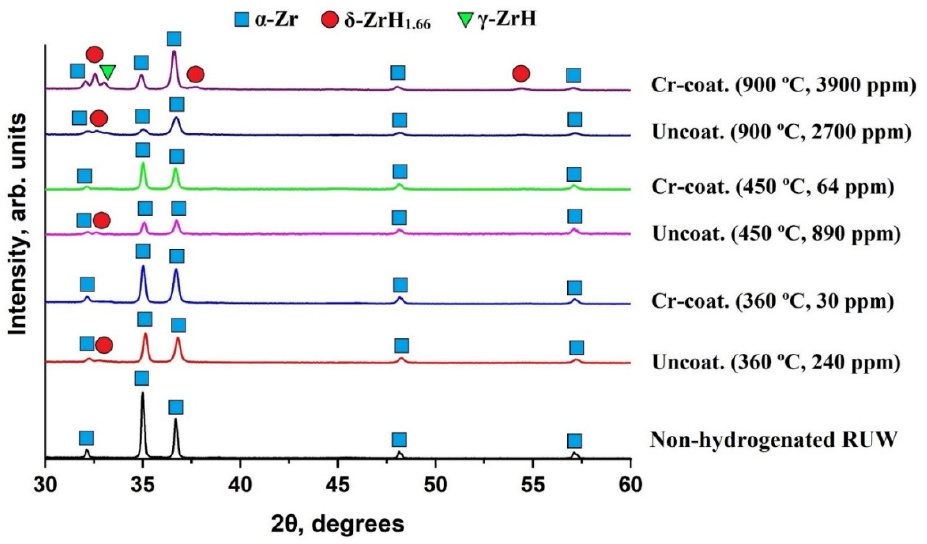
Figure 3. XRD patterns of Cr-coated and uncoated RUW specimens after hydrogenation test.